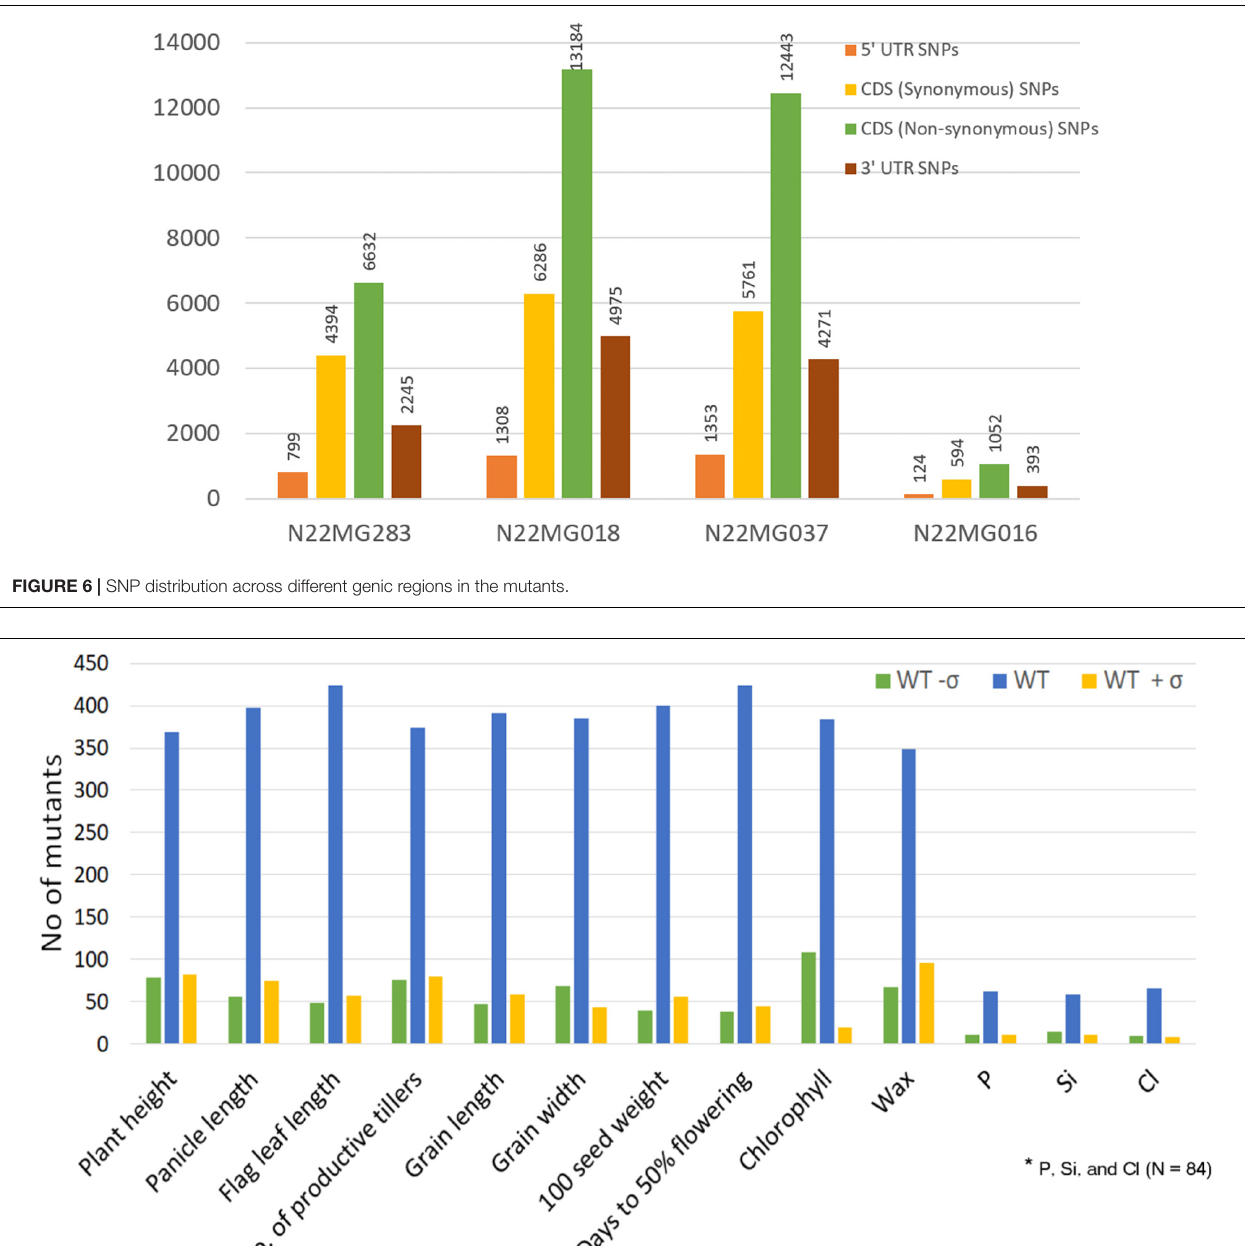
FIGURE 7 | Distribution of the mutants beyond ± 1 standard deviation for the morphological traits and organic and inorganic constituents. This is to show that the mutants with extreme trait value are available for each